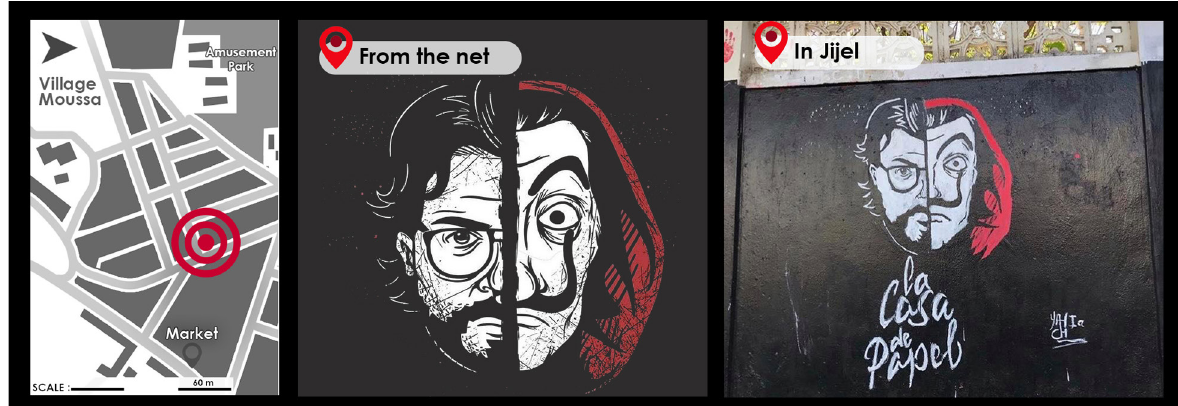
Fig. 8. Mural ‘ la casa de papel’ . On the left as is seen on the web ( La casa de papel 2019). On the right in Jijel – Village Moussa area (December 20th, 2019). Source: Khelfallah 2019.